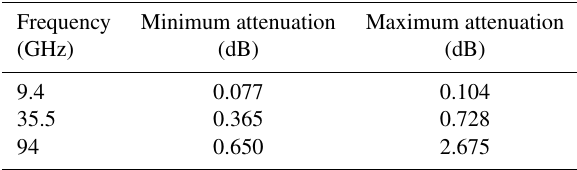
Table 3. Calculated minimum and maximum two-way path- integrated attenuation (PIA) at a height of ≈ 12km for the X, Ka, and W band during